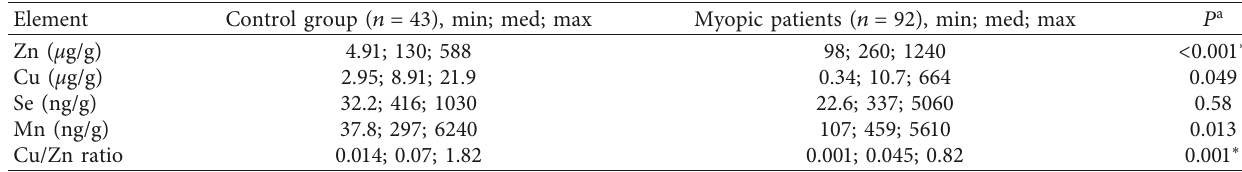
Table 3: Trace elements concentration and Cu/Zn ratio in the hair of the control group and the myopic patients. Element Control group ( n � 43), min; med;